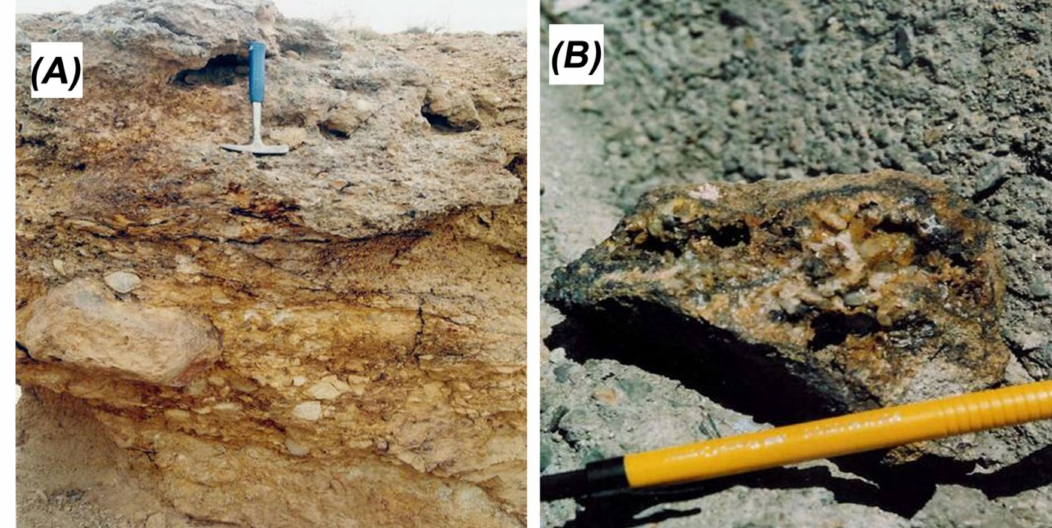
Figure 20. Gold mineralization in the Nabi-Jan area. ( A ) View of quartz-sulfide veins that developed at the top of an intrusive body of granodiorite; ( B ) Close view of quartz-sulfide gold mineralization in a hand